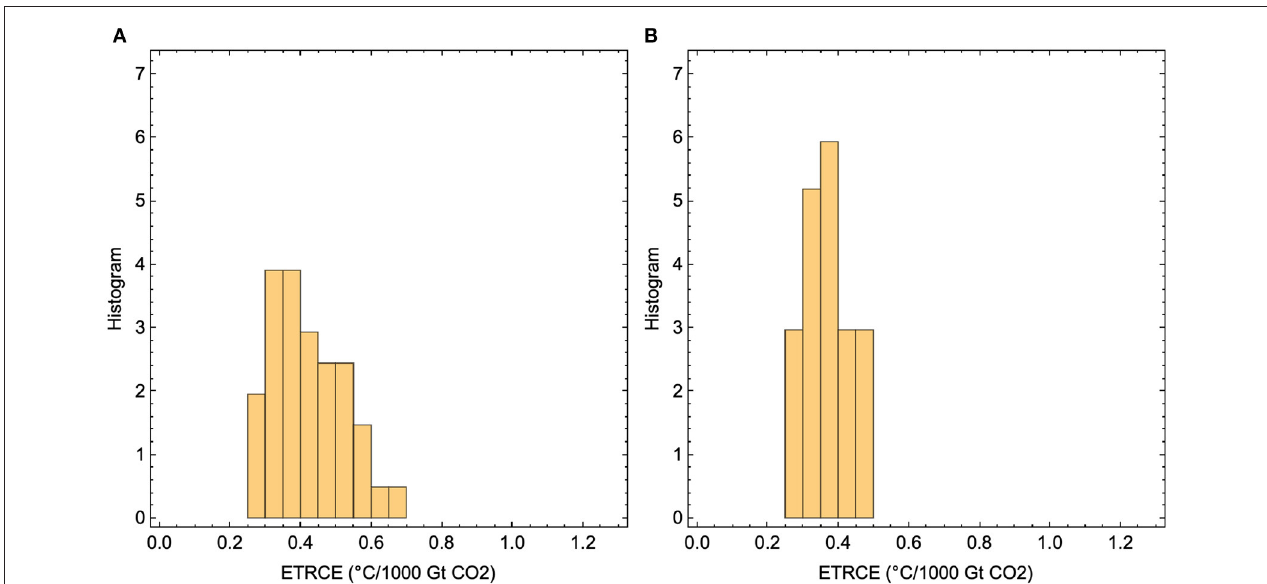
FIGURE 5 | (A) The histogram of ETCRE-values obtained by using the full set of temperature-response models. (B) The histogram of ETCRE-values obtained using only temperature response models informed by CMIP6 models with TCR in the range 1.3–2.2 K.